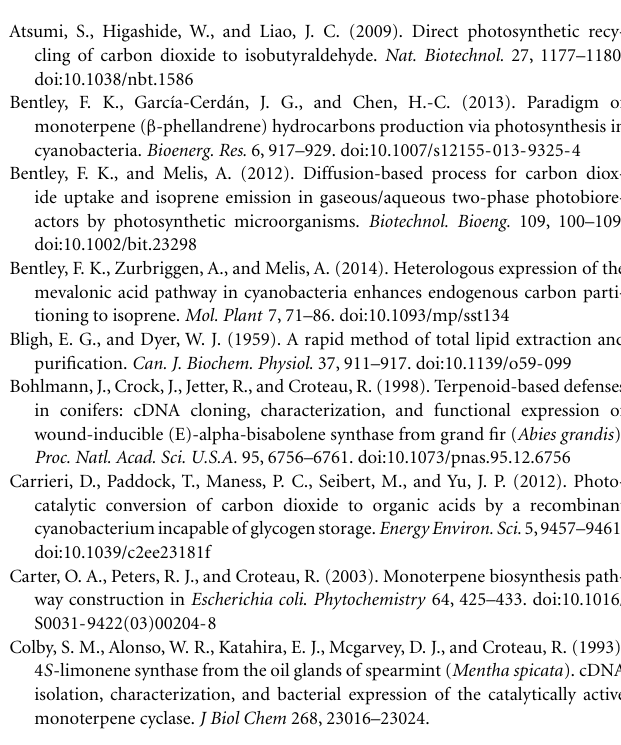
the culture medium (red crosses), a suite of organic acids were secreted from the cell as overflow metabolites from central metabolism (red boxes).There is potential to redirect these spill-over intermediates toward biotechnologically relevant pathways to increase yields of engineered products, such as limonene and α -bisabolene via the terpenoid biosynthetic